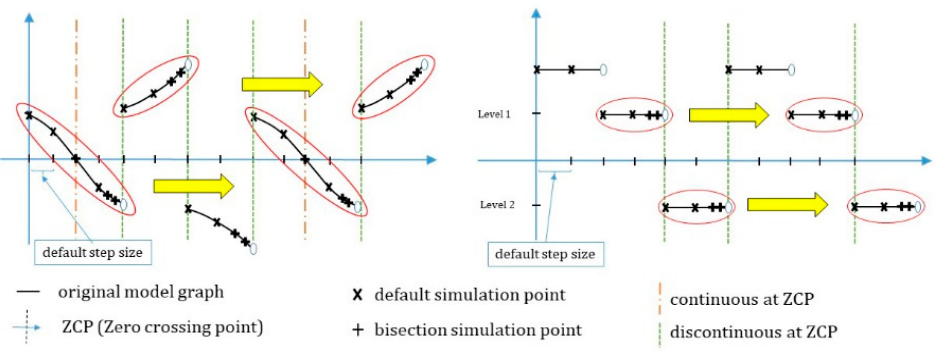
Figure 9. Example of zero crossing.